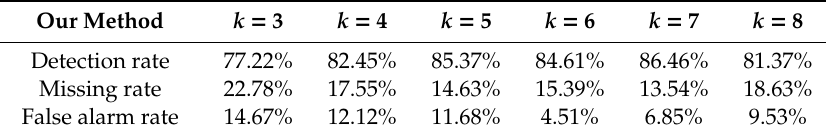
Table 4. Detection performance of di ff erent k on UNM_sendmail data.